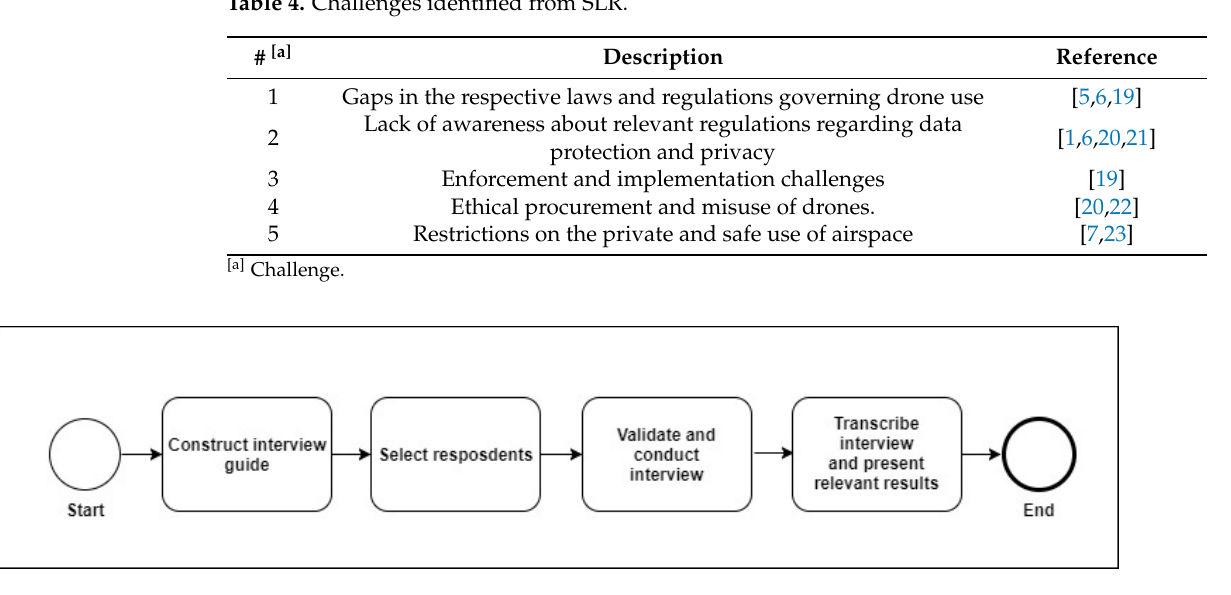
Figure 4. Survey protocol.